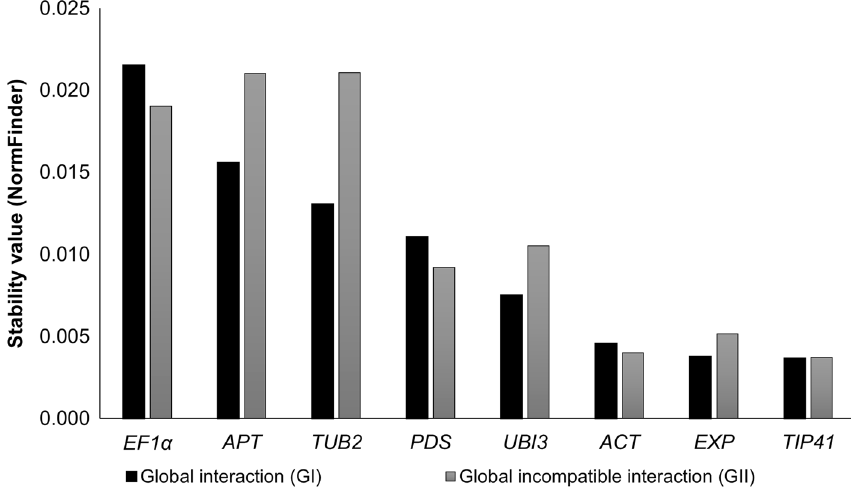
Figure 3. Stability values of eight tomato genes/alleles employed [viz. actin ( ACT ), adenine-phosphoribosyl- transferase 1 ( APT ), β-2-tubulin ( TUB2 ), elongation factor 1-alpha ( EF1α ), the Arabidopsis thaliana expressed protein ( EXP ), TIP41-interacting protein ( TIP41 ), phytoene desaturase ( PDS ), and ubiquitin ( UBI3 = UBQ )] by NormFinder algorithm for normalization of gene expression by RT-qPCR employed in the assays involving tomato ‘Hawaii 7996’ in interactions with incompatible/avirulent + compatible/virulent Ralstonia solanacearum isolates. Analyses were carried out with data from the Global Interaction #01 (see Table 1) and the Global Incompatible Interaction #02 (see also Table 1), at 24- and 96-h post-inoculation (HPI), and comparing to mock-inoculated control plants (0